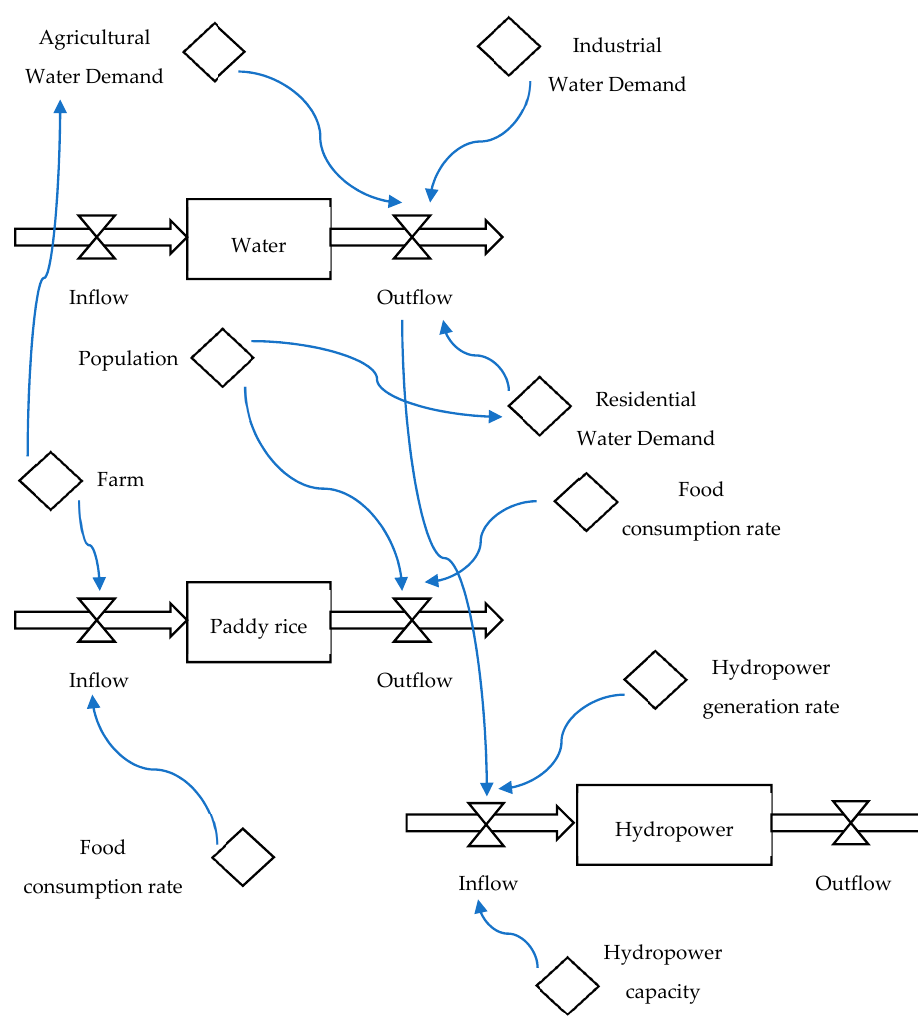
Figure 3. System dynamics simulation of food-water-energy system for urban metabolic analysis.